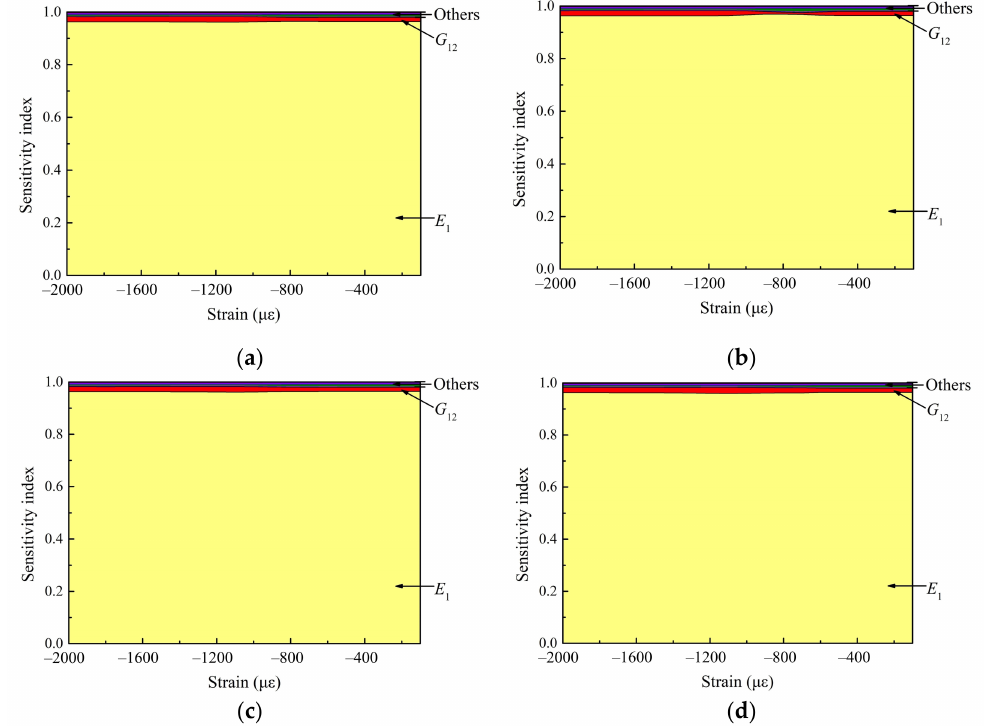
Figure 11. The SA results of each property to load under different strains in stage 1. ( a ) SA results at MP2; ( b ) SA results at MP3; ( c ) SA results at MP8; ( d ) SA results at